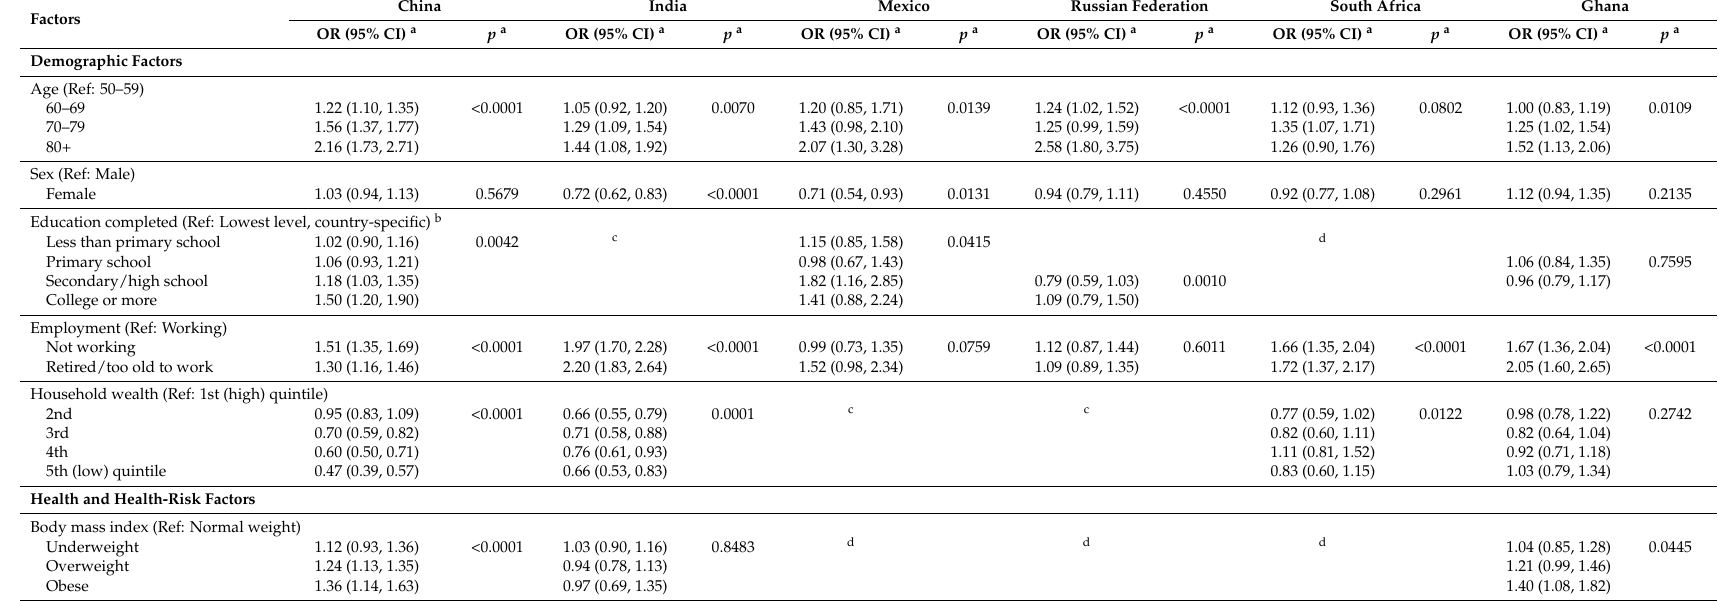
Table 4. Multivariate associations of ≥ 4 h/day sedentary behavior with demographic, health and health risk, functional, interpersonal, and environmental factors.